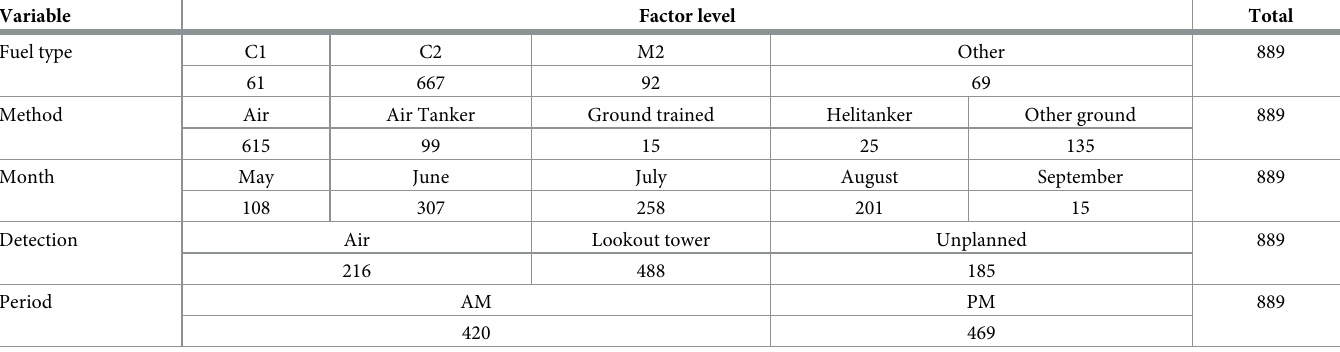
Table 2. Frequencies of factor levels among all 889 fires, for all categorical variables.